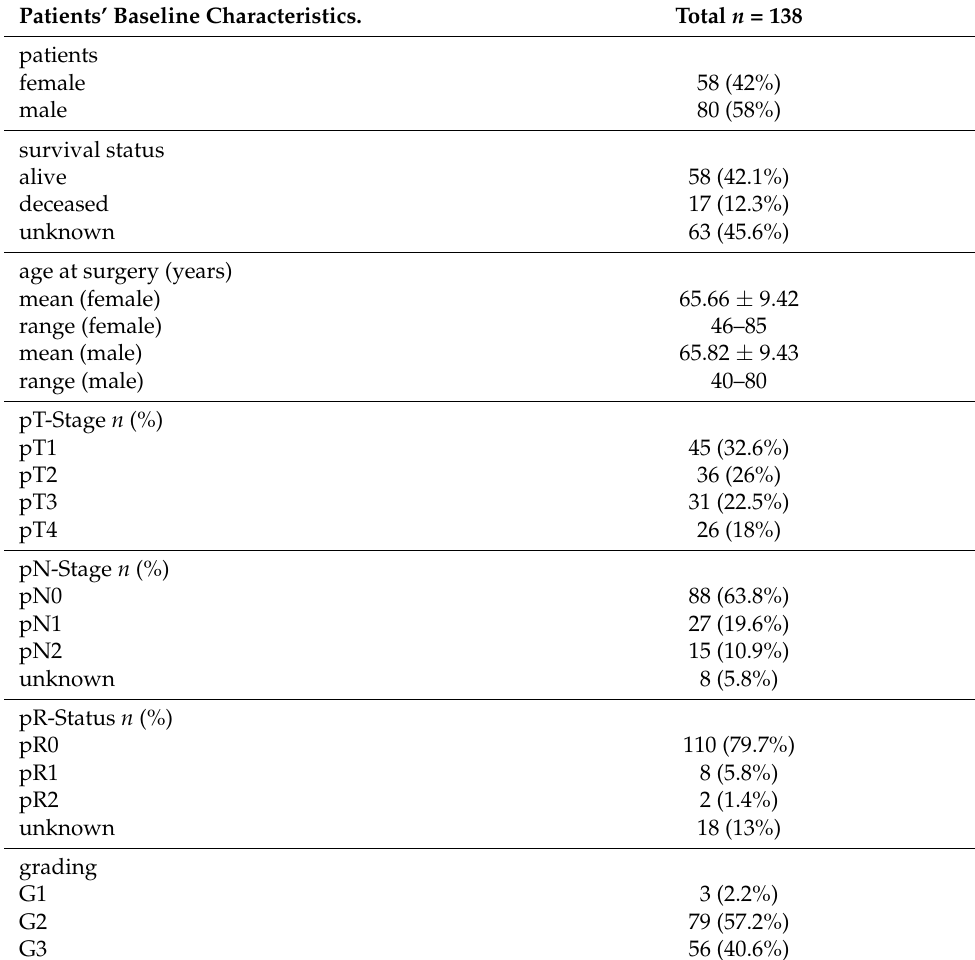
Table 1. Patients’ baseline characteristics. Patients’ Baseline